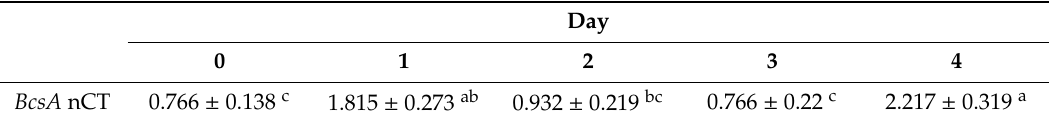
Table 3. Changes in expression of the gene bcsA from planktonic cells used to form Salmonella pellicles over a 4-day time period 1,2 .